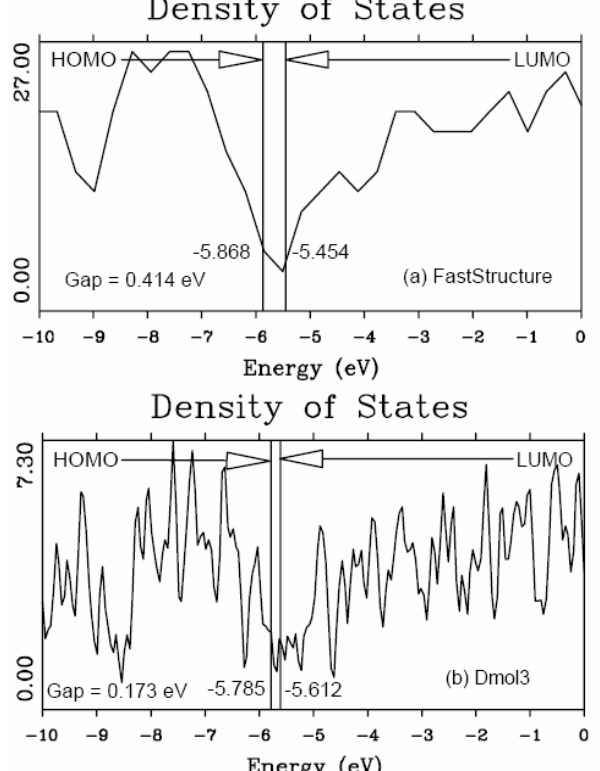
Figure 33. eDOS curves for the 2.44 fs cell of a- Si calculated using F AST , curve ( a ), and DM OL 3, curve ( b ). HOMOs, LUMOs and gaps are